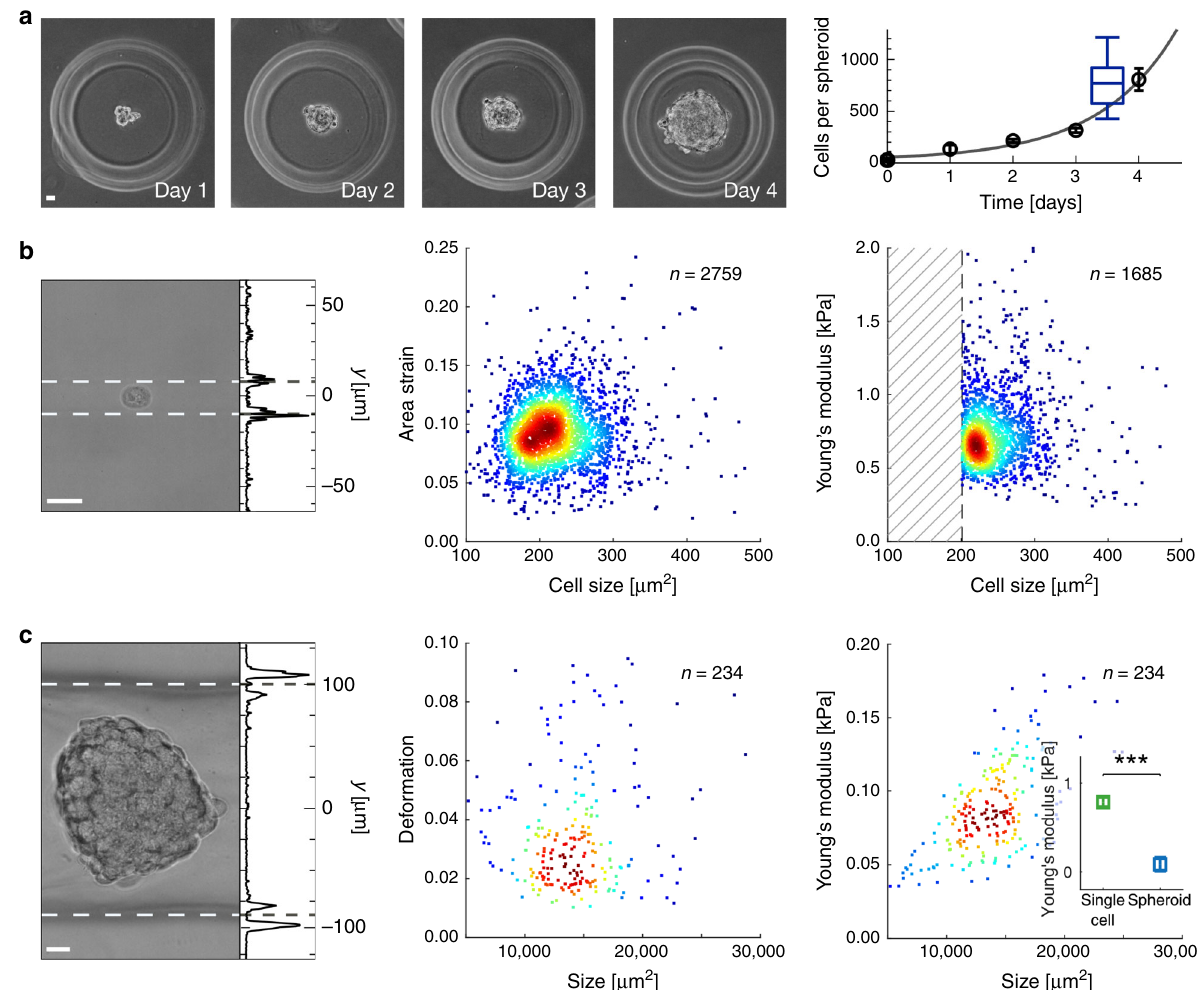
Fig. 6 High-throughput cell and tissue mechanics inside glass cuvette. a Bright- fi eld images of HEK293T spheroids obtained at four subsequent days inside agarose mold. Initial seeding density is ∼ 30 cells per micro well (left). Exponential fi t (solid line) to the mean cell number (black circles) per spheroid yields a doubling time of ~32 h. Time series has been recorded twice. Distribution of cell number per spheroid indicated in ( c , center panel) is represented in blue box plot showing median (center line), 25 and 75 percentiles (lower and upper box bound) as well as 10 and 90 percentiles (whiskers). b Representative image of a HEK293T cell in virtual channel of 16 µ m diameter (sample 114 µ M MC at Q sa = 20 nl s − 1 , sheath 5 mM PEG40000 at Q sh = 1000 nl s − 1 , left). Corresponding scatter plots of area strain (center) and Young ’ s modulus (right) versus HEK293T cell size. Young ’ s modulus is calculated from area strain assuming an interfacial stress of 66 Pa. Shaded area indicates cells not con fi ned inside the virtual channel. c Representative image of HEK293T spheroid in virtual channel of 190 µ m width (sample 114 µ M MC at Q sa = 330 nl s − 1 , sheath 5 mM PEG40000 at Q sh = 200 nl s − 1 , left). Projected line plots in ( b ) and ( c ) indicate the squared intensity gradient (arb. units) perpendicular to the fl ow direction while centers of the intensity maxima identify the virtual channel interfaces (dashed white lines). Corresponding scatter plots of deformation (center) and Young ’ s modulus (right) versus HEK293T spheroid size. Inset in right graph compares Young ’ s modulus of single cells ( E = 0.79 ± 0.06 kPa) and spheroids ( E = 84 ± 78 Pa) from three independent biological replicates consisting of n = 2433 single-cell and n = 762 spheroid measurements ( p = 0.0003). Scale bar is 20 µ m. Color in scatter plots indicates a linear density scale from min (blue) to max (red). Statistical data analysis is performed using linear mixed models and data are represented as mean ± standard error of the mean (*** p <